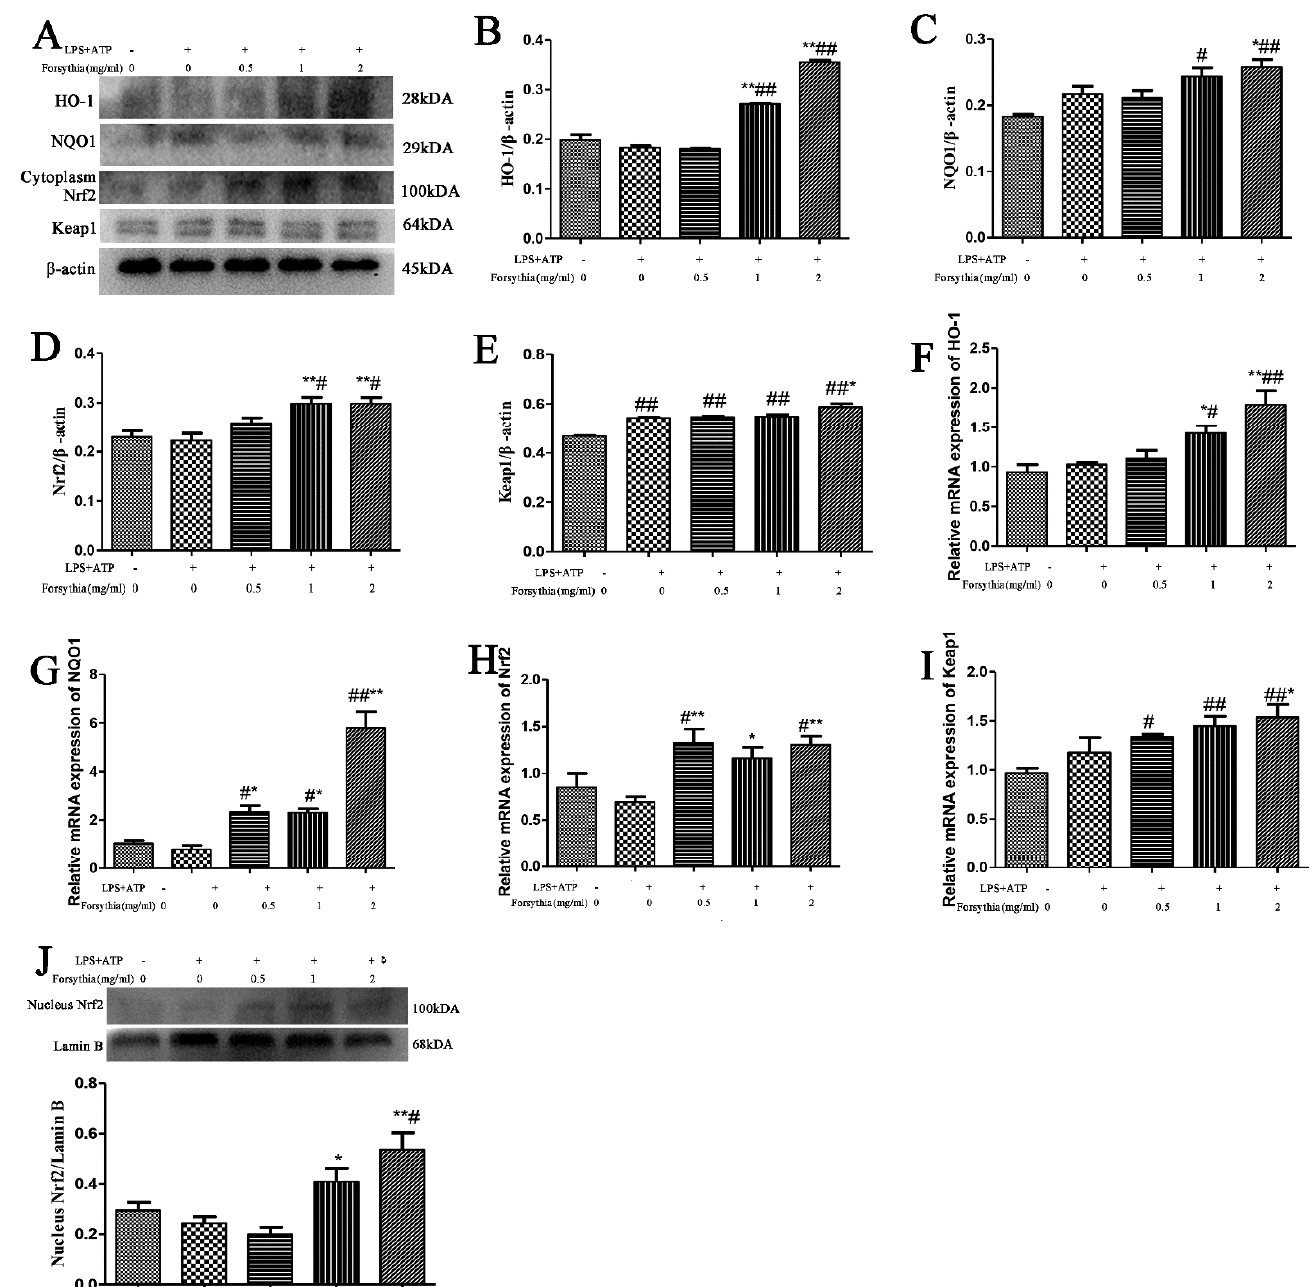
Figure 6. Forsythia suspensa extract enhances the antioxidant activity J774A.1 cells. ( A – E ) Western blot analysis of HO-1, NQO1, and cytoplasm for Nrf2 and Keap1. ( F – I ) qRT–PCR detection of HO-1 , NQO1 , Nrf2 and Keap1 gene expression levels. ( J ) Western blot analysis of the level of nuclear Nrf2. The results are shown as the mean ± SEM. # p < 0.05, and ## p < 0.01 compared with the control group; * p < 0.05, and ** p < 0.01 compared with the model group; #** means # and **; ##** means ## and **.